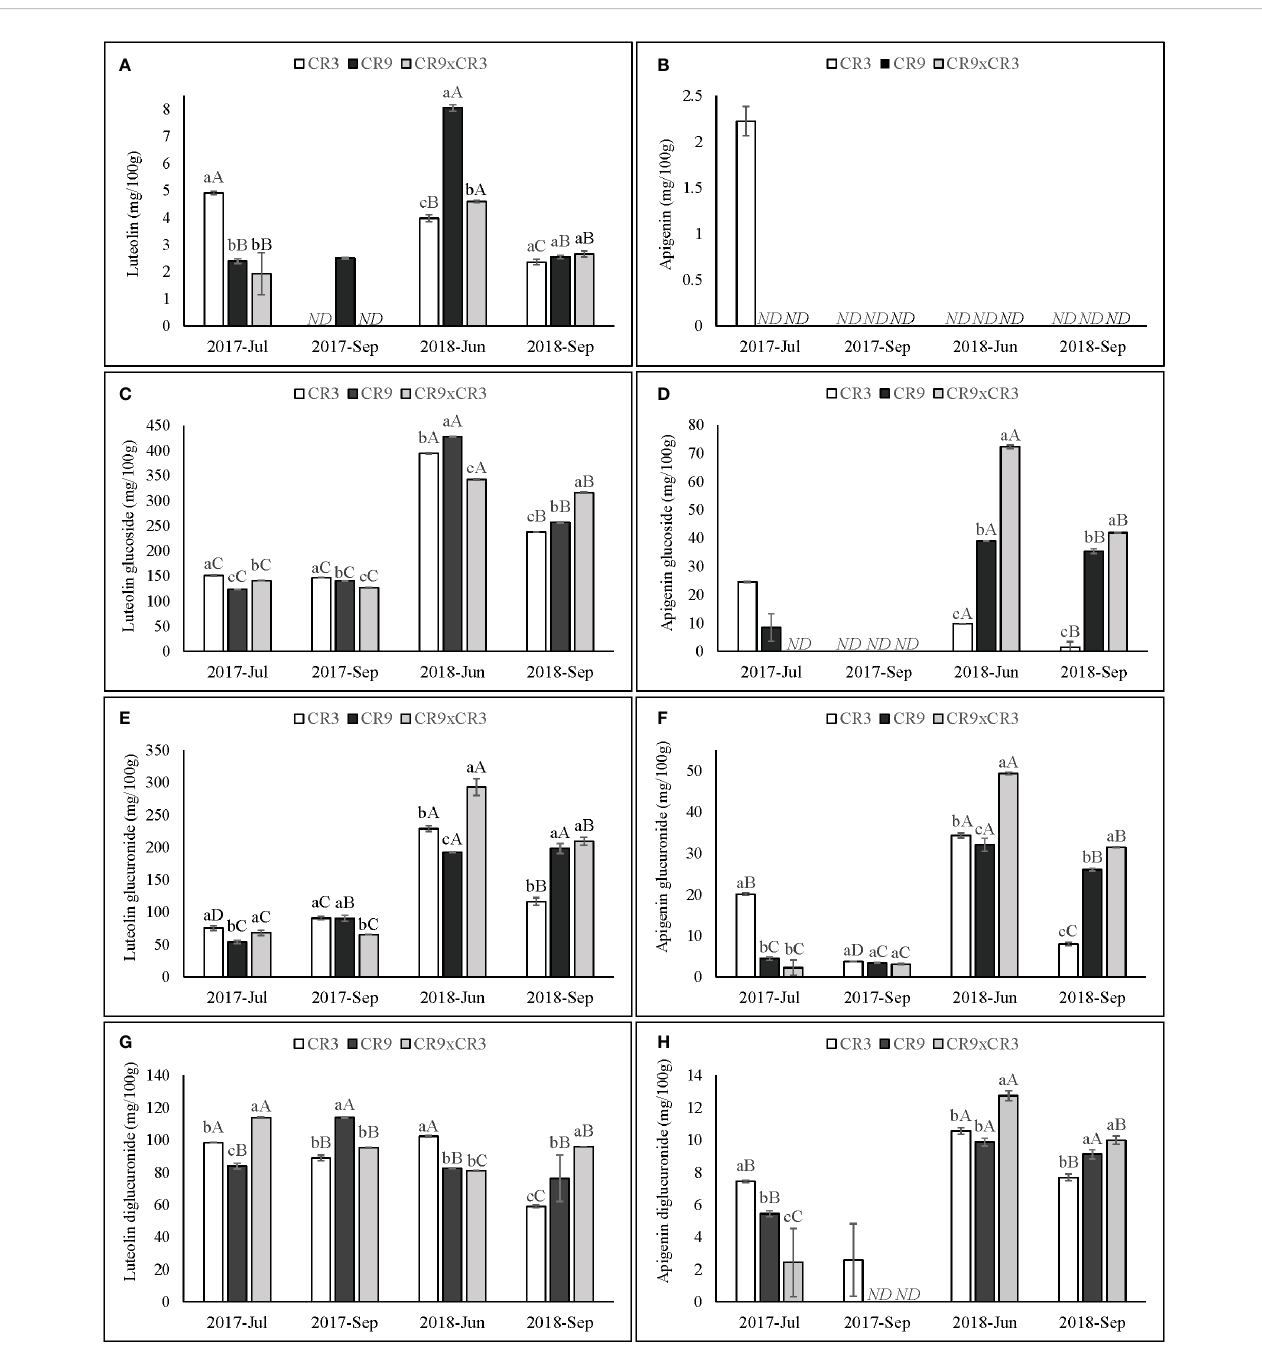
FIGURE 7 Contents of luteolin (A) , apigenin (B) , luteolin glucoside (C) , apigenin glucoside (D) , luteolin glucuronide (E) , apigenin glucuronide (F) , luteolin diglucuronide (G) and apigenin diglucuronide (H) in catnip genotypes at different harvest times. Pittstown, NJ, United States. Vertical error bars indicate standard deviation. Uppercase letters indicate statistical comparisons of the same genotype across harvests and lowercase letters indicate comparisons among the three genotypes inside the same harvest. Averages with different letters are statistically different by the Scott-Knott test (p= ≤ 0.01). ND, not detected. Harvests in which a speci fi c compound was not detected in one or more genotypes were excluded from the statistical analysis of that